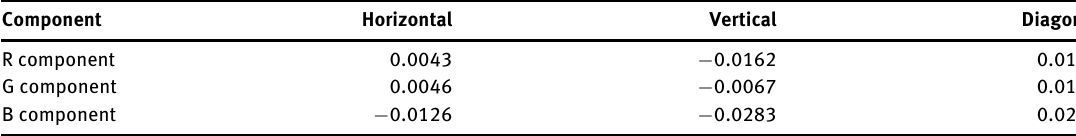
Table 1: Correlation Coeflcients of R, G, and B Channels of the Encrypted Color Image of